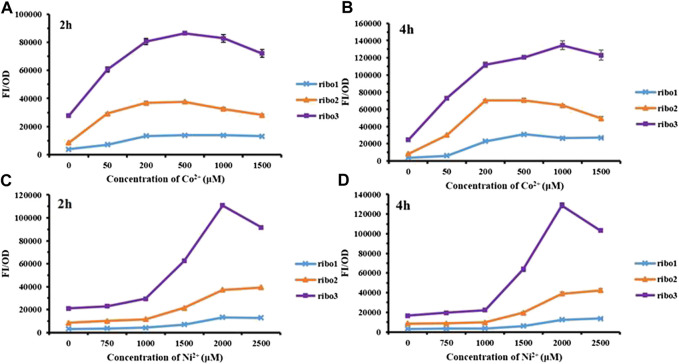
Fluorescent measurement of three parallel NiCo riboswtich sensors with concentration gradient: (A) FI/OD values were detected by 0–1,500 μM CoCl2 for 2 h. (B) FI/OD values were detected by 0–1,500 μM CoCl2 for 4 h. (C) FI/OD values were detected by 0–2,500 μM NiCl2 for 2 h. (D) FI/OD values were detected by 0–2,500 μM NiCl2 for 4 h.